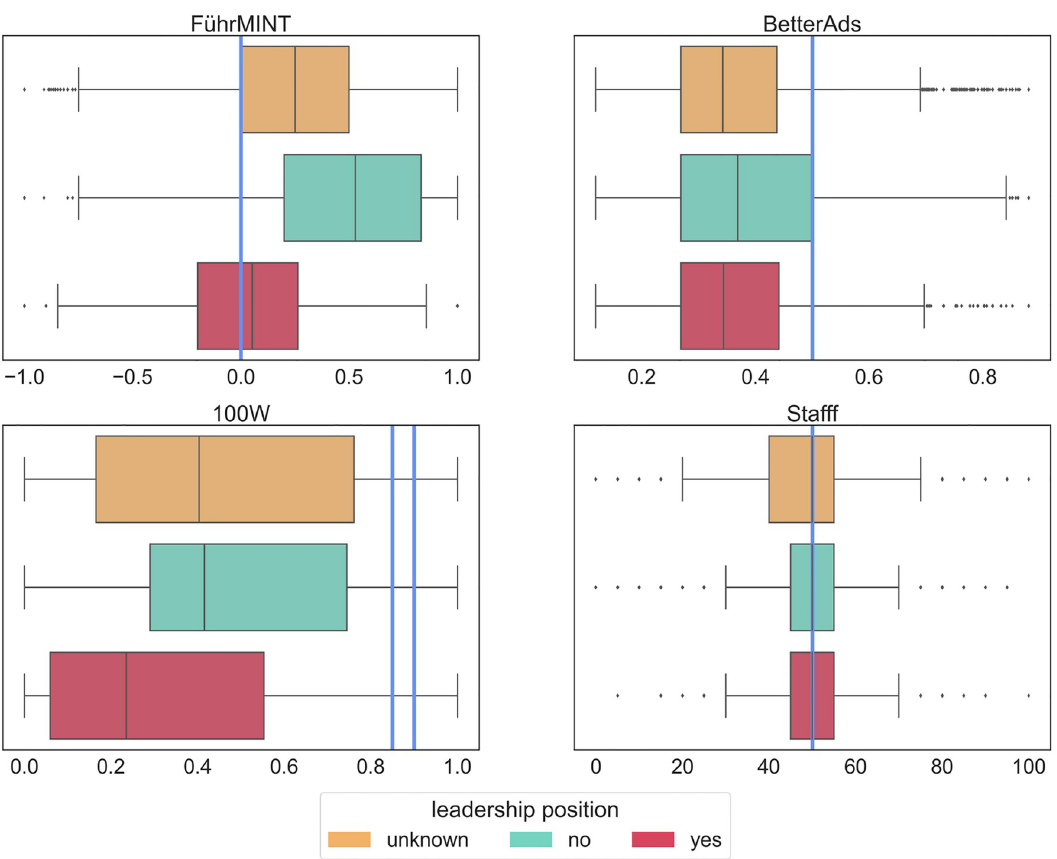
Fig 13. Box plots of the distribution of gender scores in three data samples: Leadership jobs, jobs without leadership requirements, and jobs for which leadership information is not known.